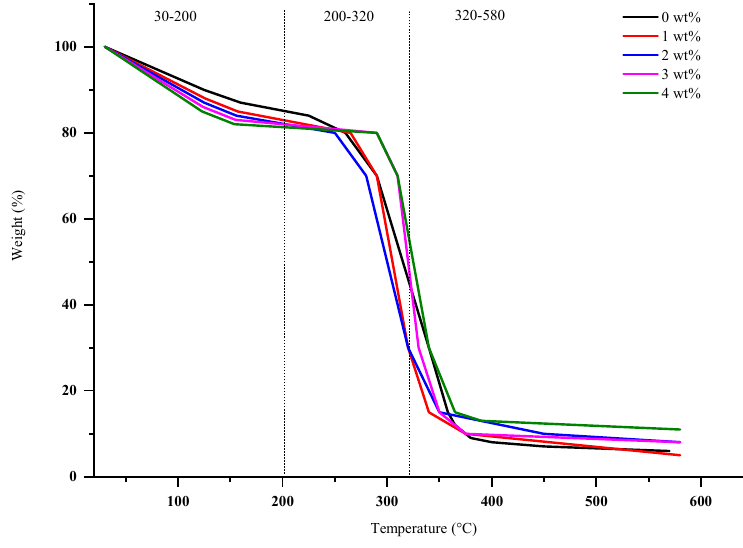
ff erences in the TGA Figure 5. Degradation phase differences in the TGA analysis. Figure 5. Degradation phase di